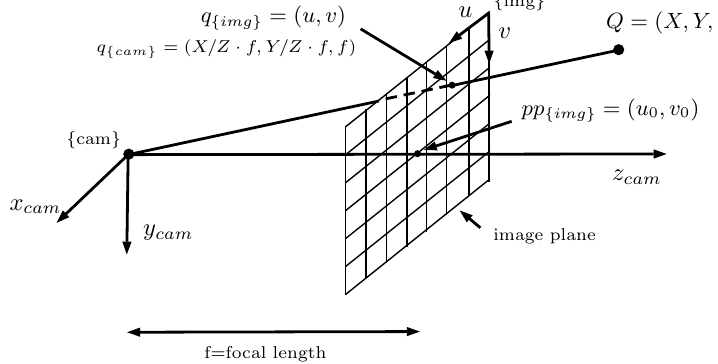
Figure 7. The pinhole camera